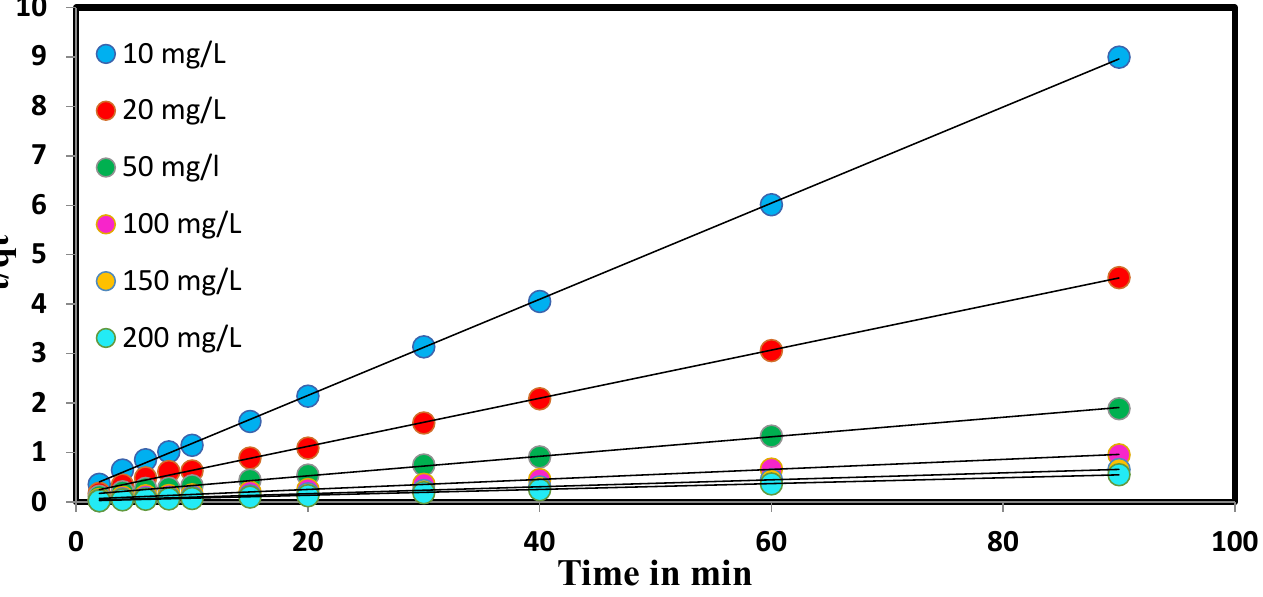
Figure 3. MD kinetic plots on PbO@MgZnO at different initial MD concentrations.